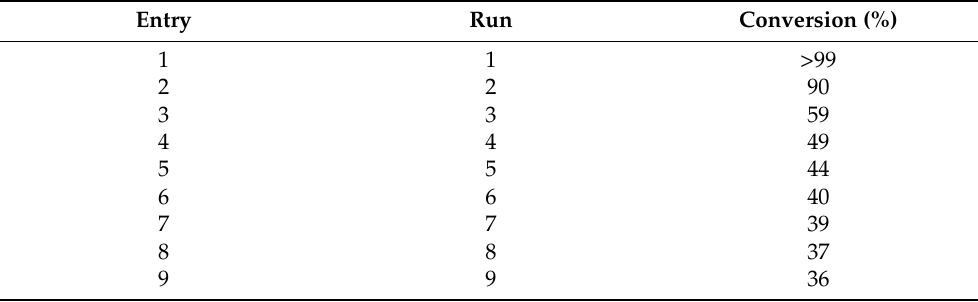
Table 5. Recycling experiments for the liquid phase hydrogenation of 4-nitrobenzonitrile, facilitated by CoCorrPPh 3 @Vulcan-800. Reaction conditions: 4-nitrobenzonitrile (0.5 mmol), catalyst (0.5